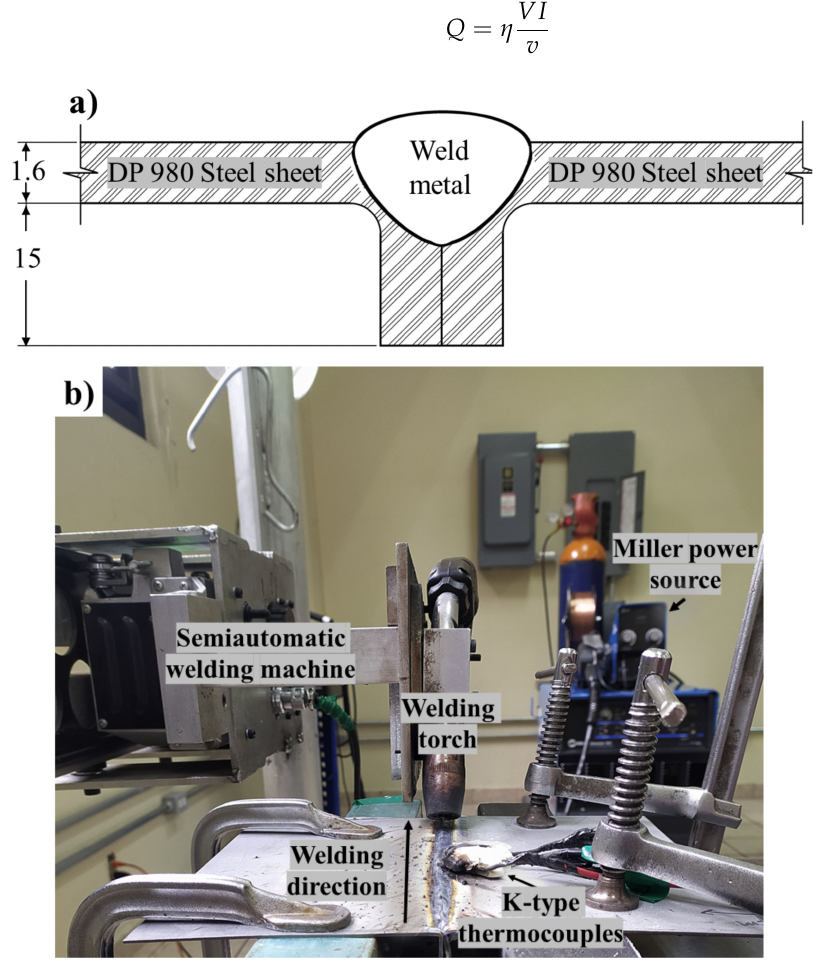
Figure 1. Configuration for welding process of DP980 steel sheets ( a ) Schematic draw for the joint geometry with a standard flare V-groove preparation, dimensions are in mm. ( b ) Experimental